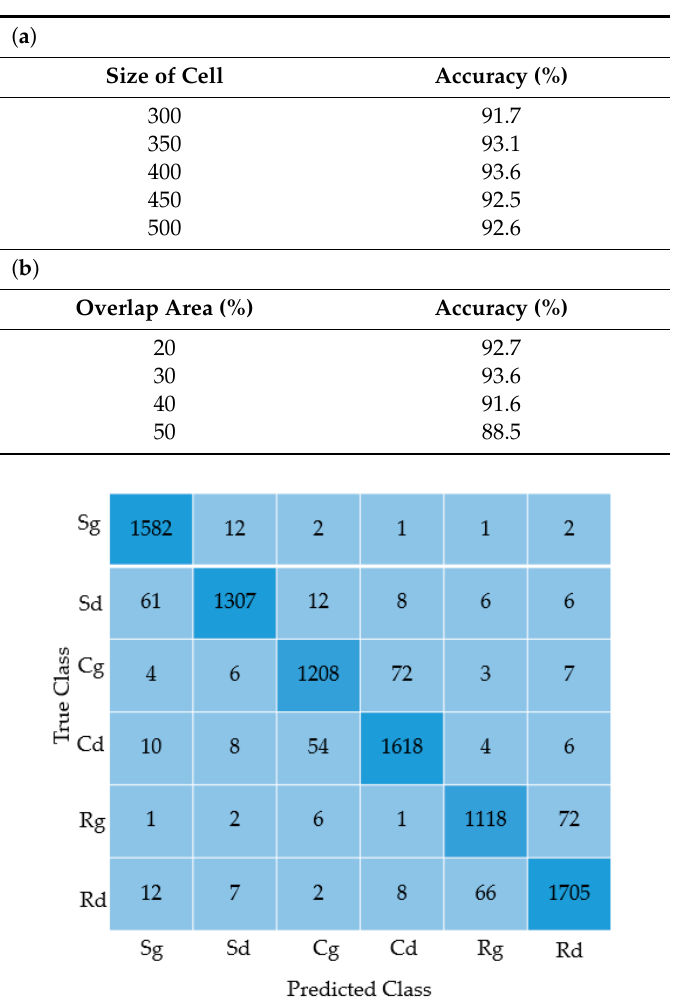
Table 1. We compared the accuracy of models with di ff erent sizes of superpixel cell ( a ) and with di ff erent overlap areas of superpixel cell ( b ).